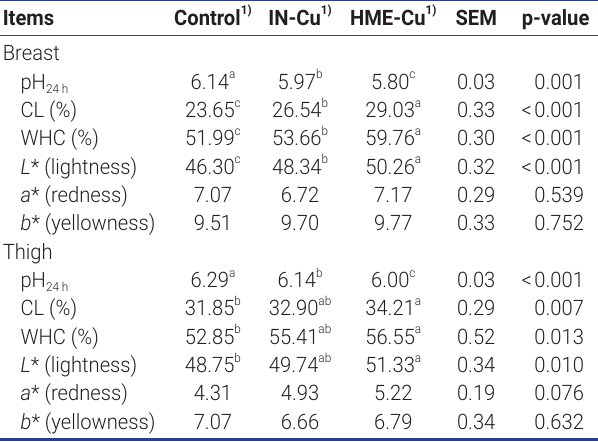
Table 7. Effect of dietary Cu concentrations and sources on meat quality in broilers Items